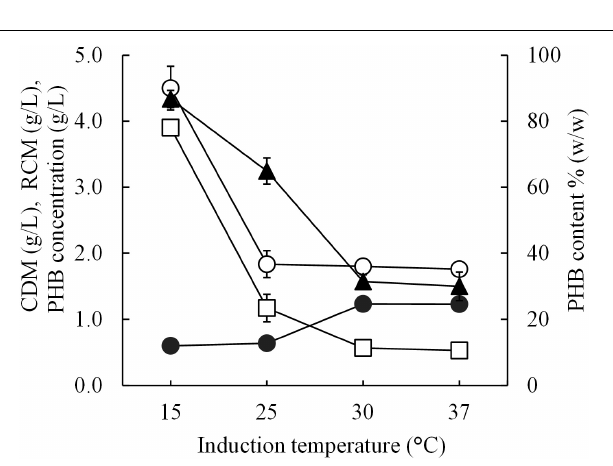
FIGURE 5 | Effect of different short-induction temperatures (15, 25, 30, and 37 ◦ C) on the CDM (g/L), RCM (g/L), PHB (g/L), and PHB content (% w/w) of E. coli JM109 (pColdI- phaCAB A - 04 ). All the data are representative of the results of three independent experiments and are expressed as the mean values ± standard deviations (SDs). Symbols: open circle, CDM (g/L); closed circle, RCM (g/L); open square, PHB (g/L); closed triangle, PHB content (%